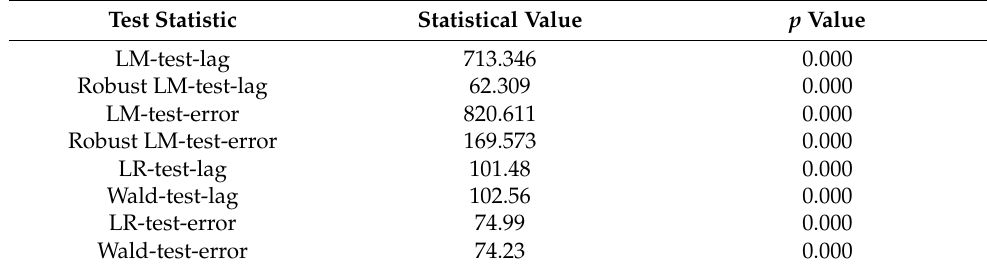
Table 4. LM, LR, and Wald